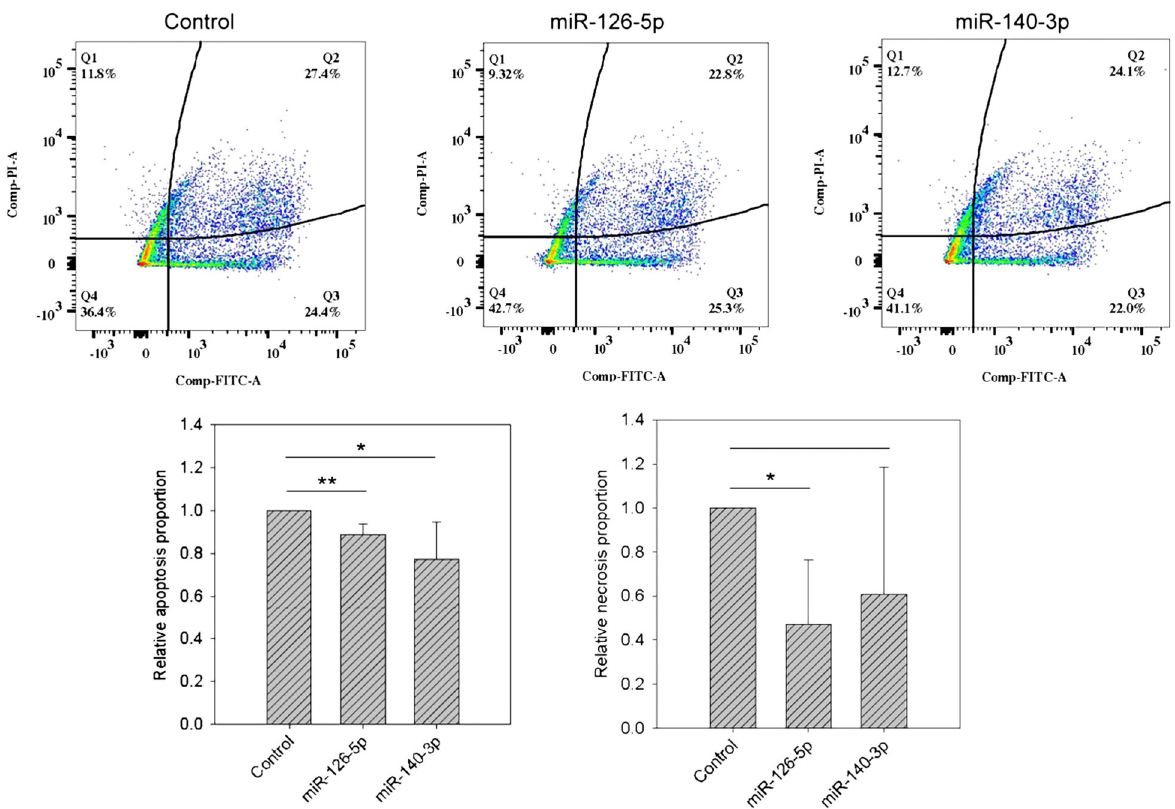
Fig. 4 Flow cytometry assay results. We used a fl ow cytometry assay to determine the proportion of cells undergoing apoptosis and necrosis. The upper sub fi gures denote the results of one fl ow cytometry run. Through four independent assays, we quanti fi ed the proportions of cells undergoing apoptosis and/or necrosis in the lower sub fi gures. * and ** denote p value < 0.05 and p value < 0.01,